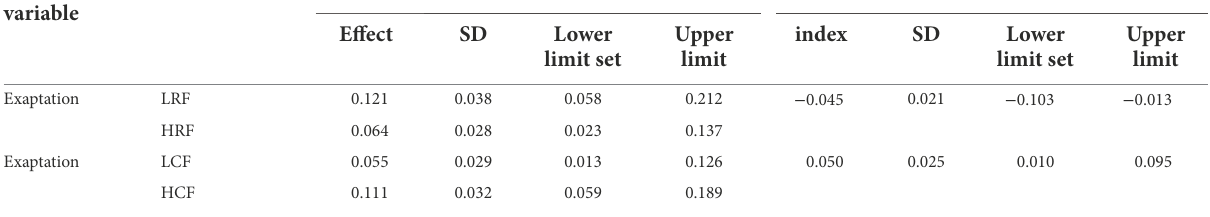
TABLE 4 Test results of the moderated mediation